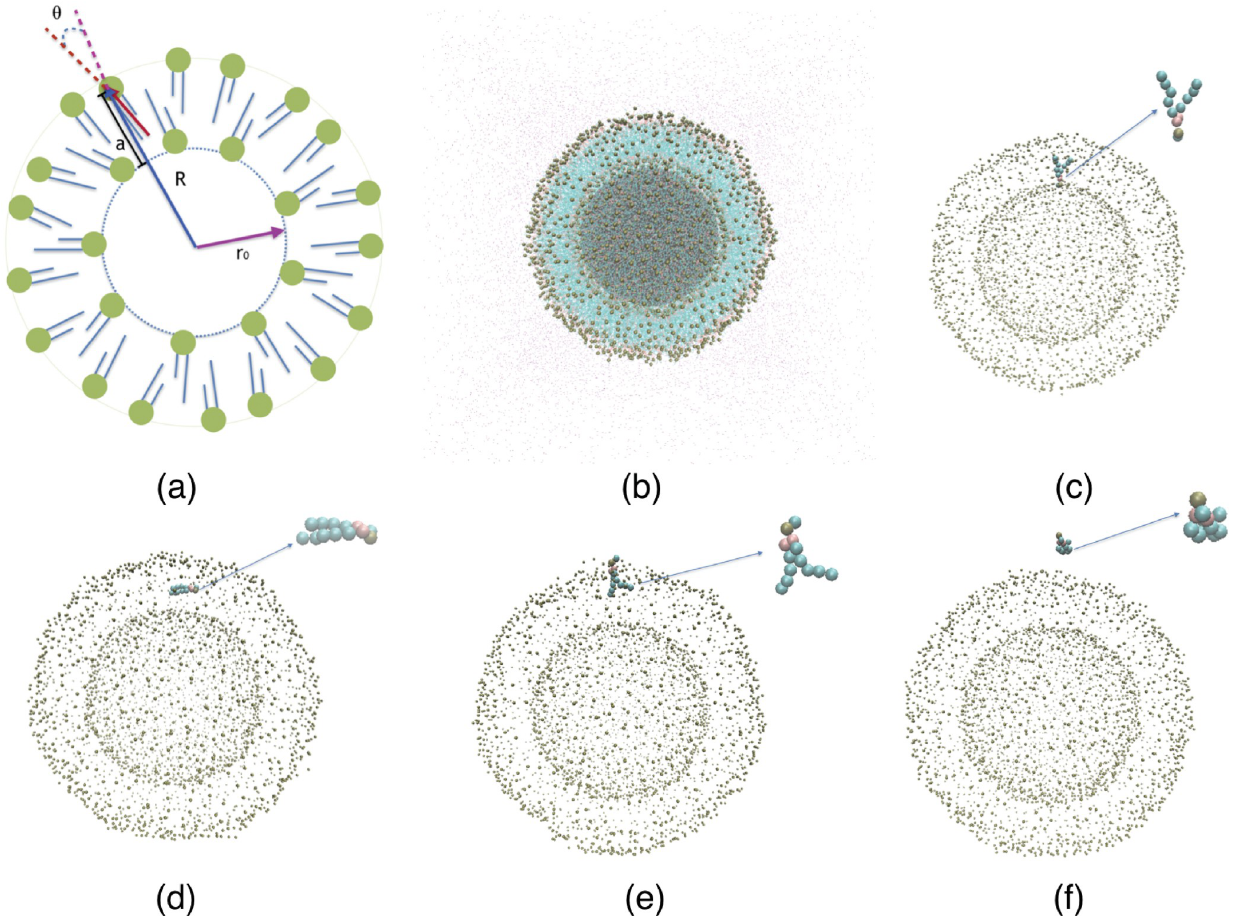
Fig 3. The schematic depiction of the geometry of the NPSLBL (system A). (b) MD simulation snapshot of the NPSLBL; only 1/10 th of the total number of water molecules are displayed for a clearer view. (c-f) Snapshots representing the positions (and configurations) of a single lipid molecule (zoomed in the inset showing the corresponding lipid configuration) corresponding to its different locations inside and outside the LBL of the NPSLBL. These different locations are (c) inner leaflet, a = 0 Å ; (d) hydrophobic core, a = 22 Å ; (e) outer leaflet, a = 44 Å ; (f) bulk water, a = 70 Å . For all the cases we use the following color codes: purple for water; dark green for the planar support; light green for the hydrophobic tails of lipids; Bronze for the hydrophilic head of the lipids. For figures (c-f), only the hydrophilic heads of the lipid molecules of the LBL are displayed for a clearer view.